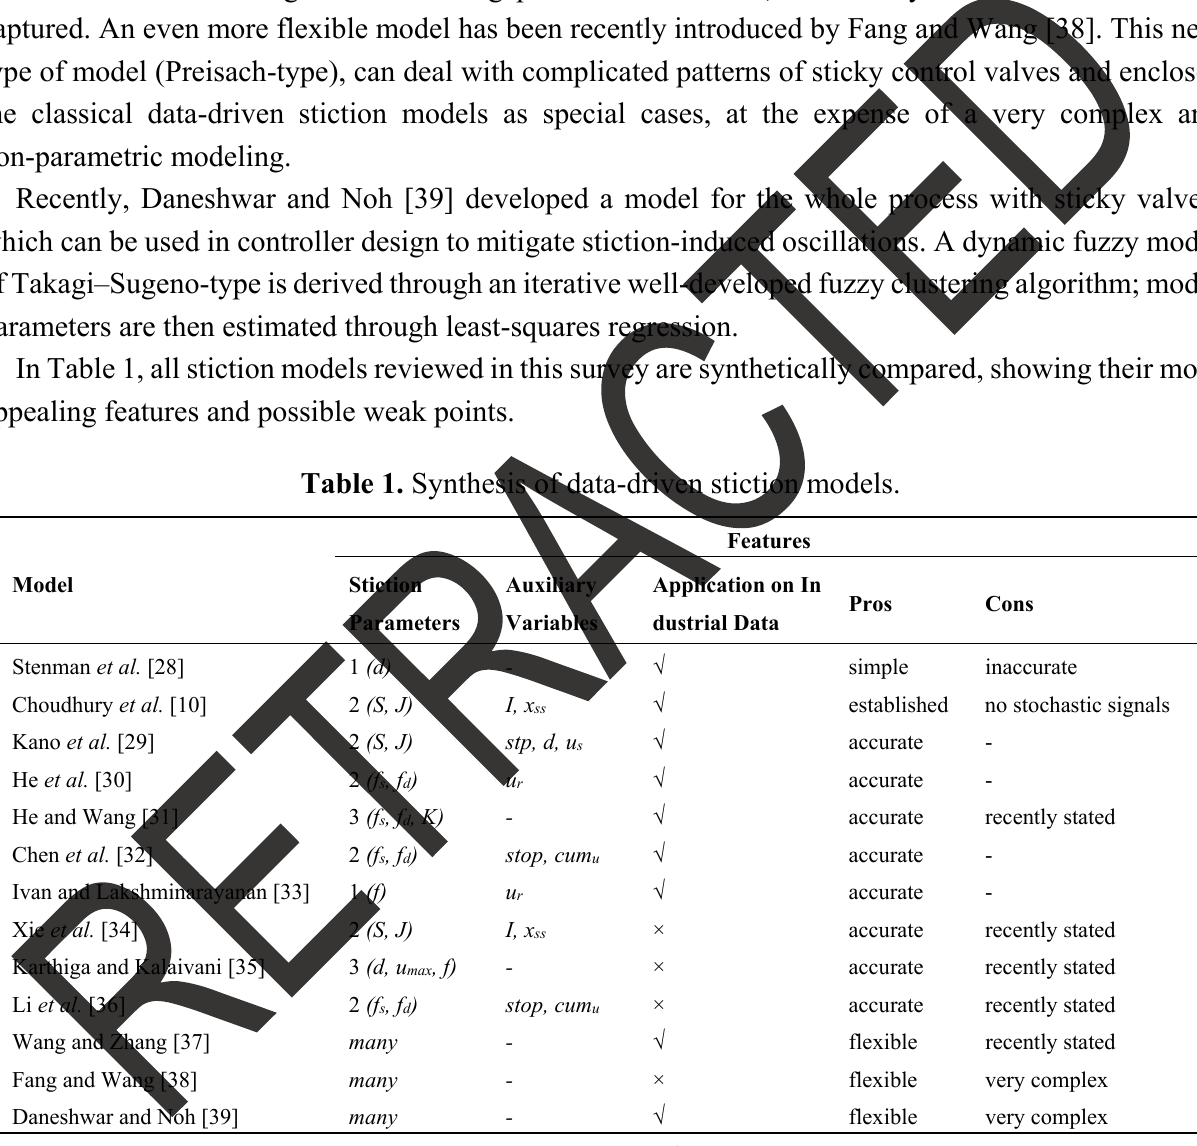
Table 1. Synthesis of data-driven stiction